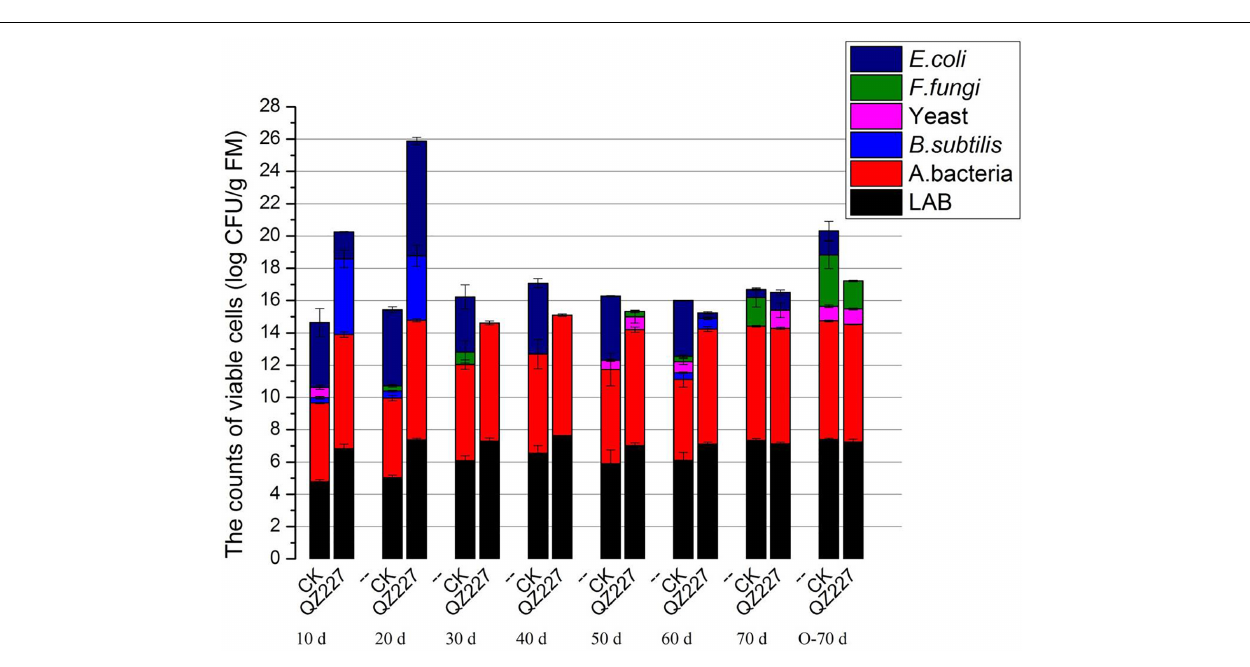
FIGURE 2 | The number of cultural microorganisms during the fermentation